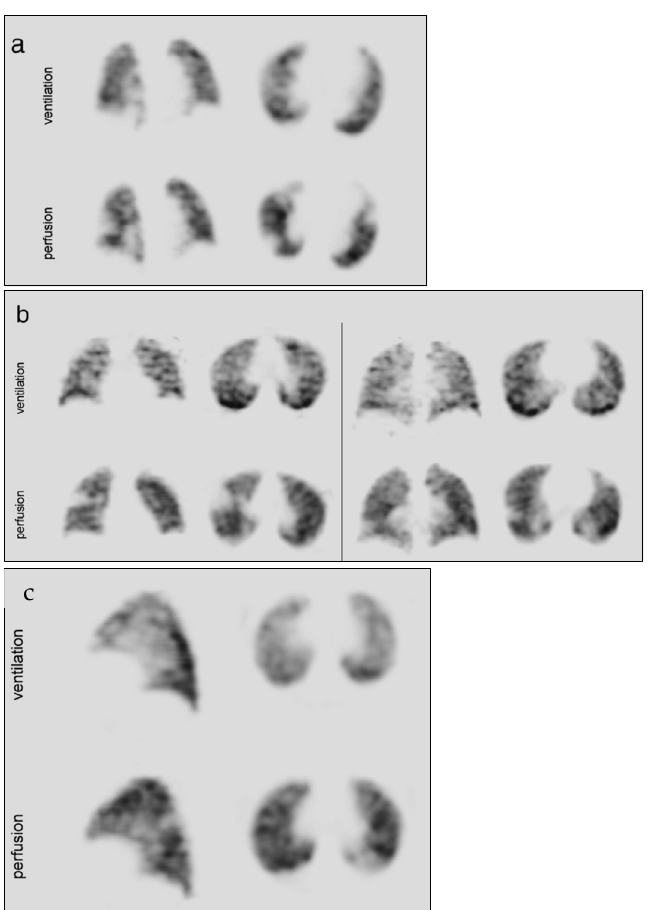
Figure 11. ( a ) A 63-year-old male with a 10-h history of right-sided pleuritic chest pain. V/Q SPECT showed multiple asymmetric wedge-shaped perfusion defects in reference to PE. ( b ) A 37-year-old male who presented with a swollen leg and chest pain. SPECT showed multiple asymmetric wedge-shaped perfusion defects in reference to PE. ( c ) A 31-year-old female who presented with shortness of breath, pleuritic chest pain, and two episodes of haemoptysis. V/Q SPECT showed a single subsegmental asymmetric perfusion defect in the left lung. Computed tomography pulmonary angiography performed the next day showed no PE, but lingular atelectasis, pericardial thickening, and a small pericardial e ff usion. Reprinted/adapted with permission from Ref. [35]. 2014, Elsevier.